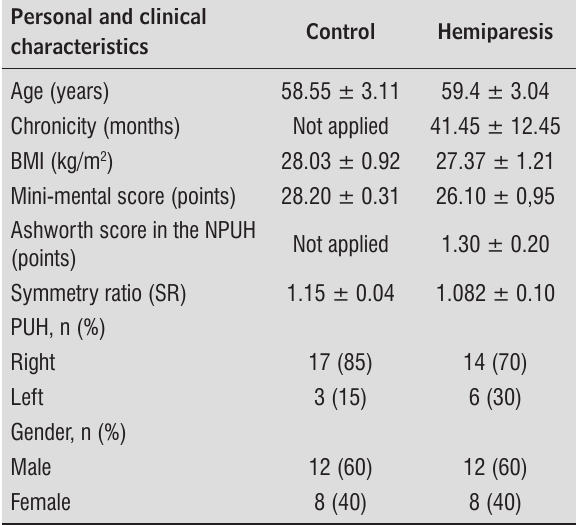
Table 1 - Personal and clinical characteristics by control (n = 20) and hemiparesis (n = 20) group